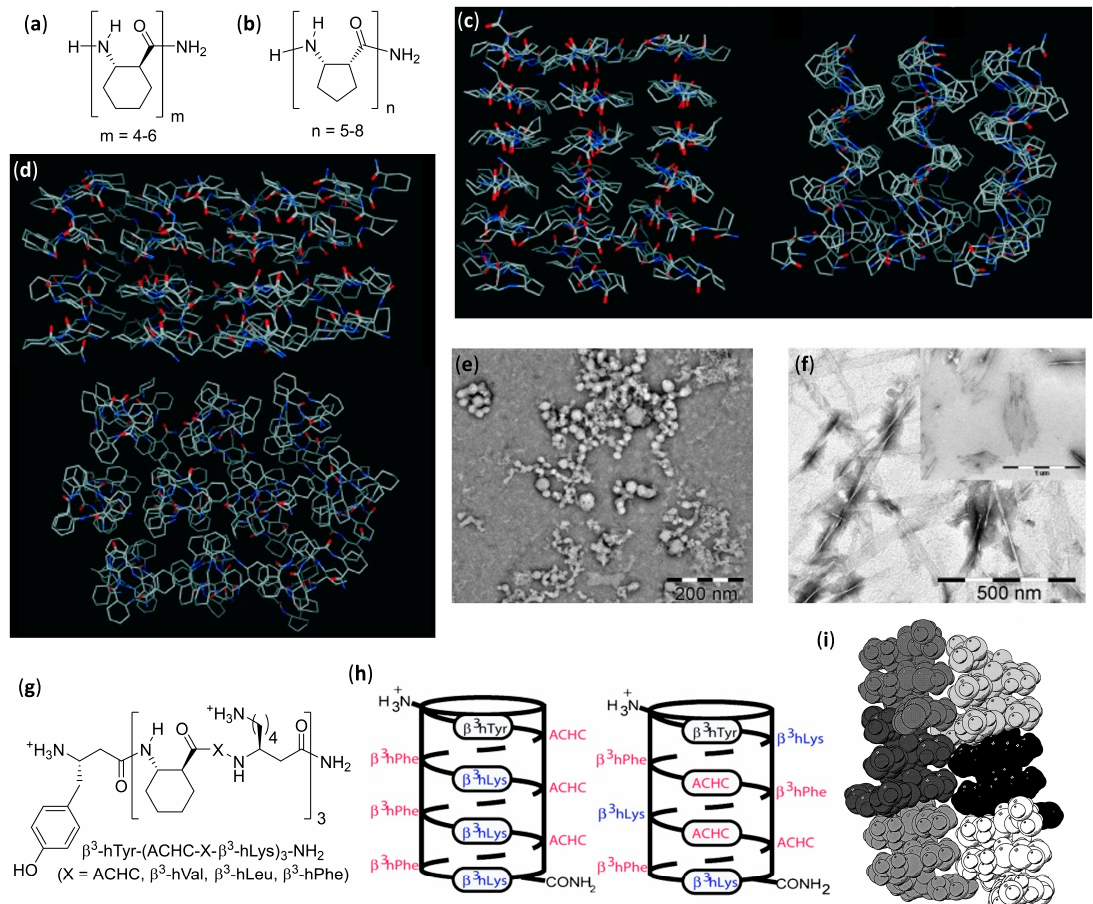
Figure 5. ( a ) H-( trans -ACHC) m -NH 2 foldamers (Refs. [8,106]); ( b ) H-( cis -ACPC) n -NH 2 foldamers (Refs. [8,106]); ( c ) Side (left) and top (right) views of a fibril fragment of H-( cis -ACPC) 7 -NH 2 after 3 ns